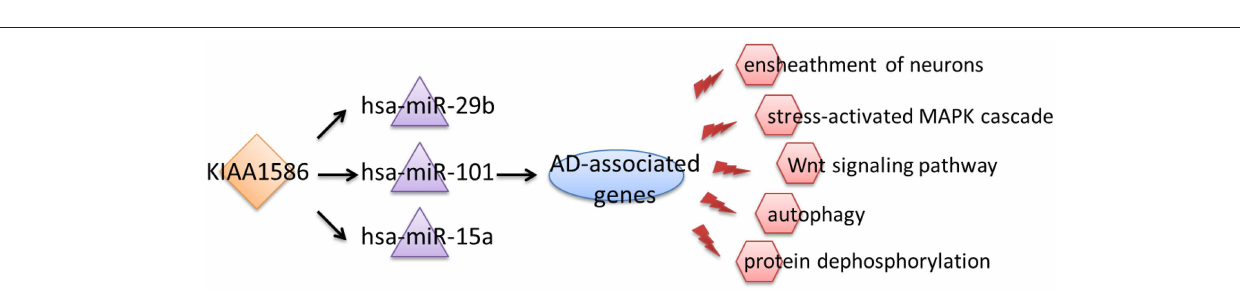
FIGURE 3 | The significantly enriched biological processes of KIAA1586 -associated ceRNAs.